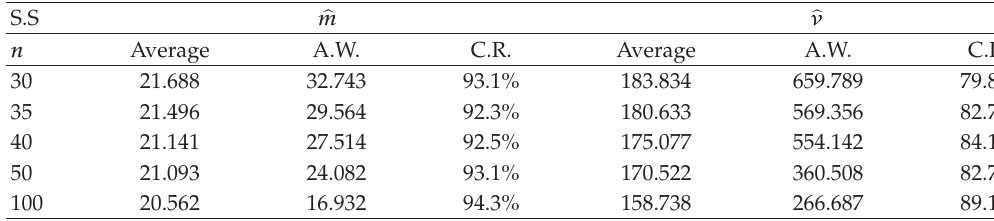
Table 5: Grouped data: τ 1 (cid:8) − 2, τ 2 (cid:8) 0, τ 3 (cid:8) 2, τ 4 (cid:8) 4, τ 5 (cid:8) 6.